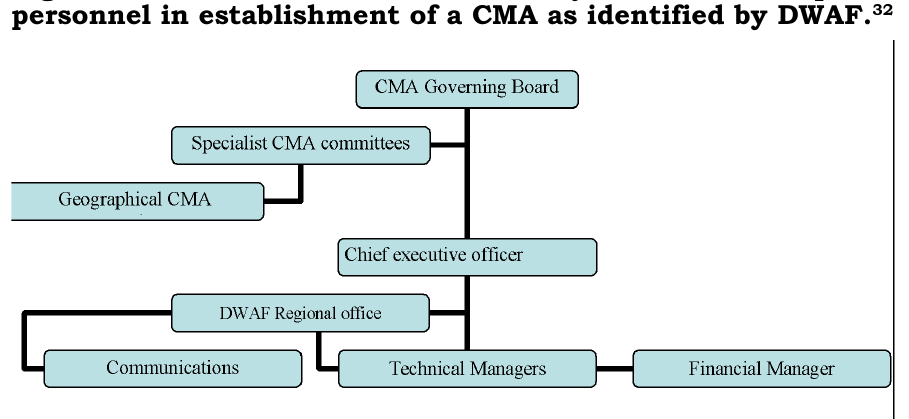
Tragedy of the commons: in the Lower Orange Figure 2: Illustration of the hierarchy of minimum required personnel in establishment of a CMA as identified by DWAF. 32